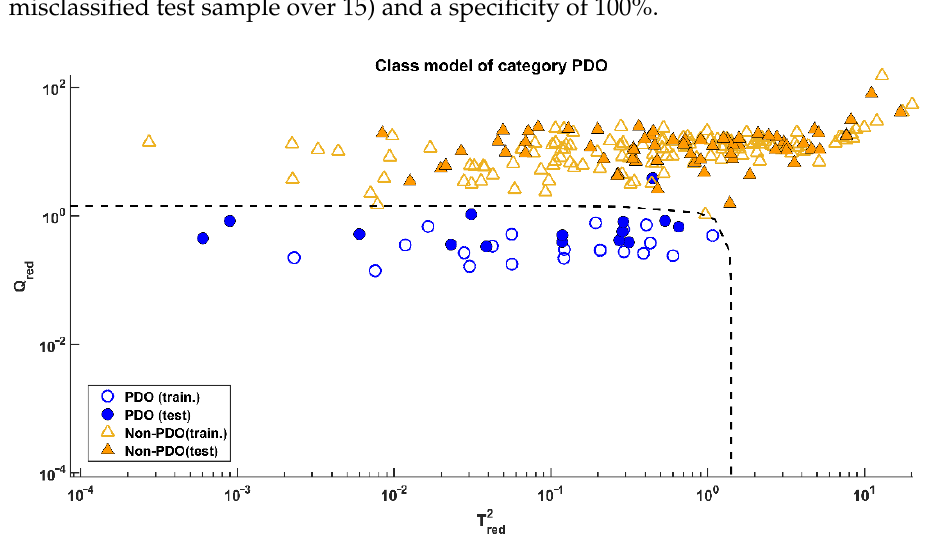
model space of class red